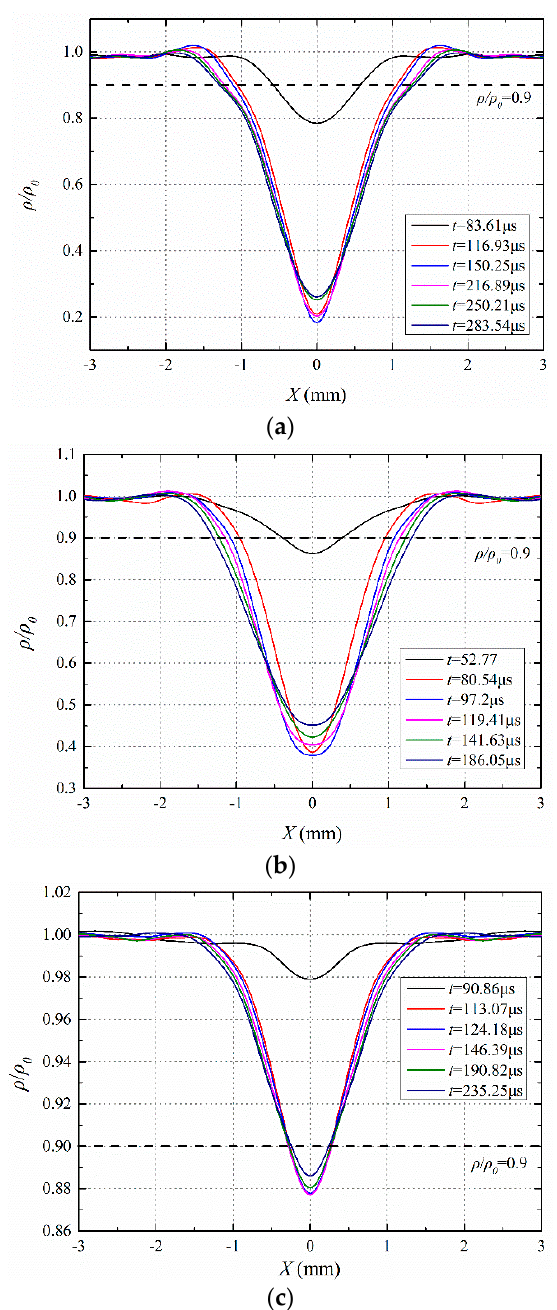
Figure 9. Density distribution: ( a ) cone terminal, radius of curvature = 2.5 mm; ( b ) cone terminal, radius of curvature = 5 mm; ( c ) spherical terminal, diameter = 40 mm.